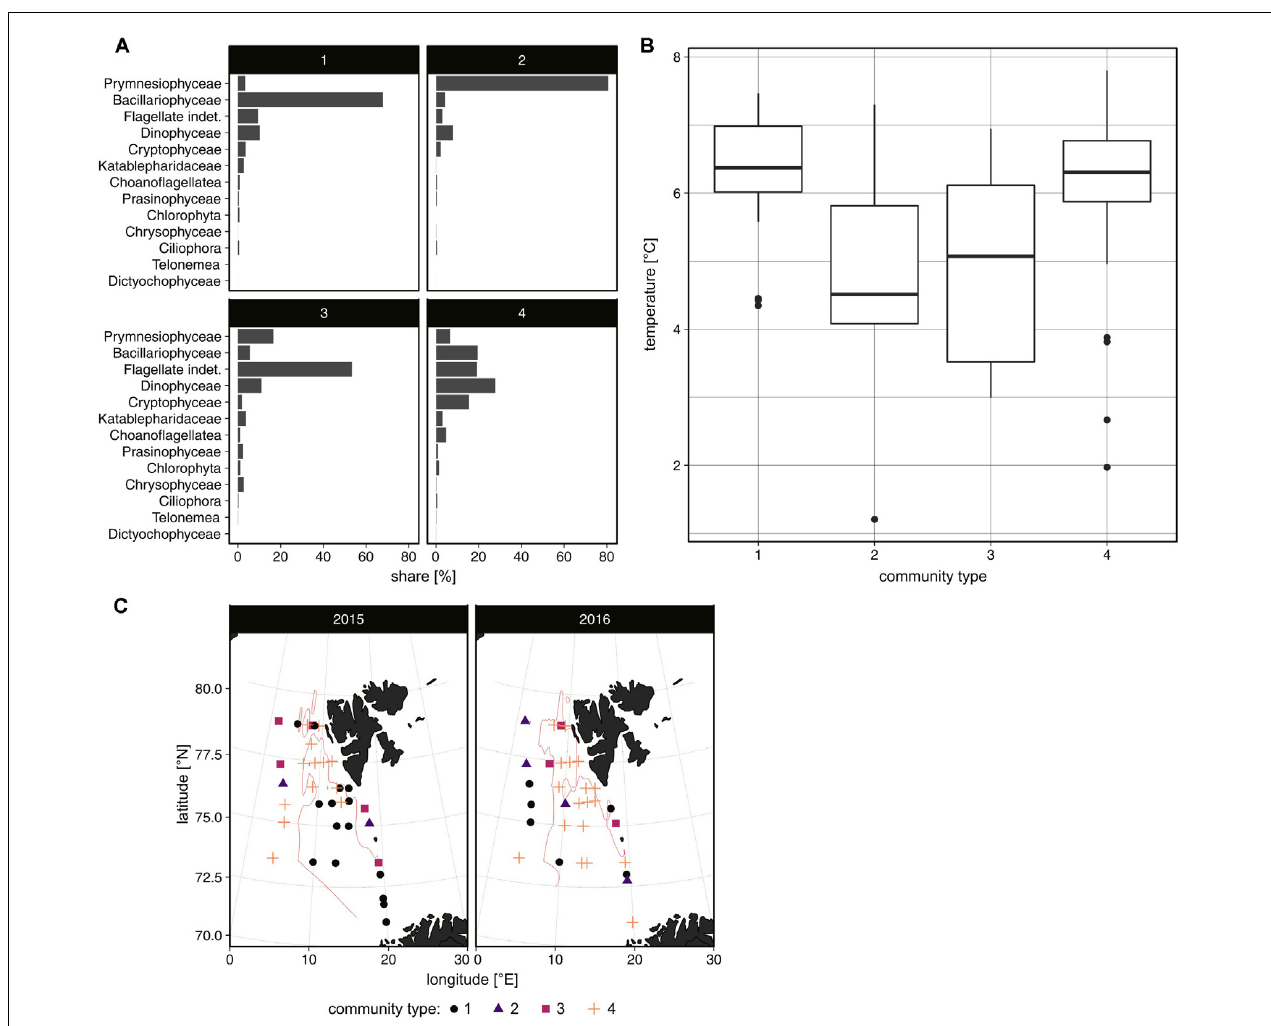
FIGURE 6 | The share [%] of protist groups in individual community types determined by k-means analysis (A) , the temperature range in their areas of occurrence (B) (both based on 2-year abundance data), and their spatial distribution in the area in the summers of 2015 and 2016 (C)